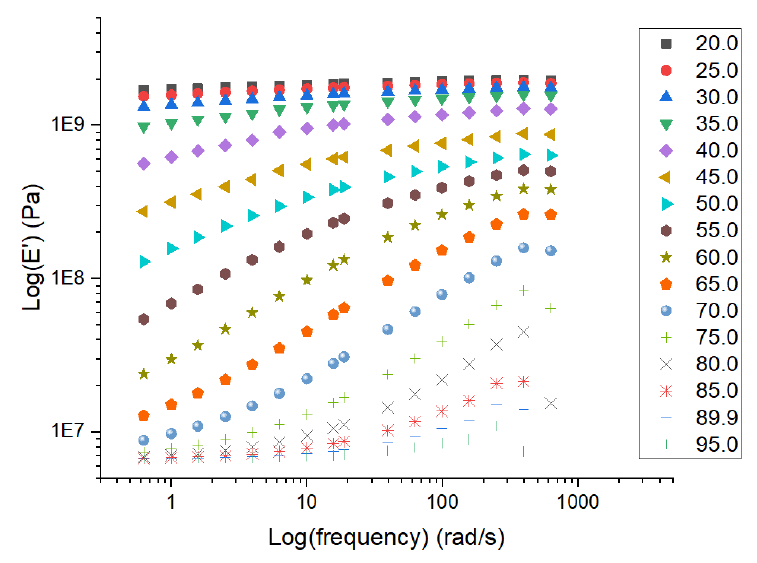
Figure 6. Storage modulus of Polymer A at various